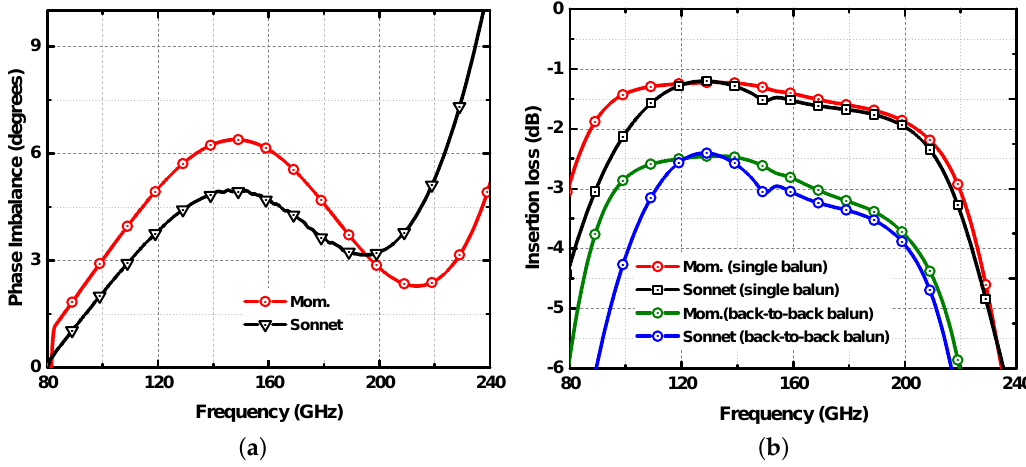
Figure 9. Simulated insertion loss ( a ) and phase imbalance ( b ) of the asymmetric coupled line balun in Sonnet and ADS